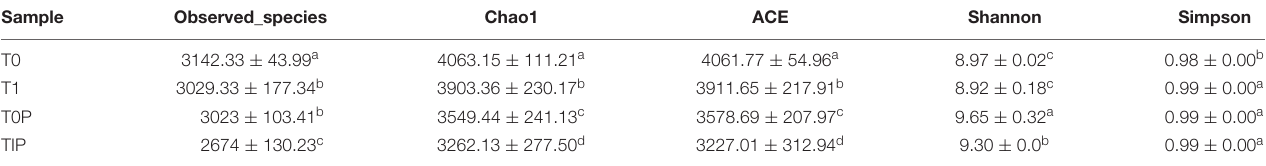
TABLE 4 | Effects of rock phosphate (RP) and phosphate-solubilizing bacteria (PSB) on richness and diversity indices of soil bacterial communities. Sample